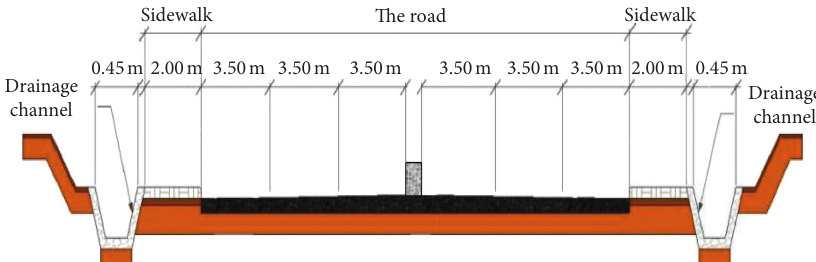
Figure 4: Typical existing condition of highway drainage canal; the design of drainage systems may vary according to the runoff calculation procedures.